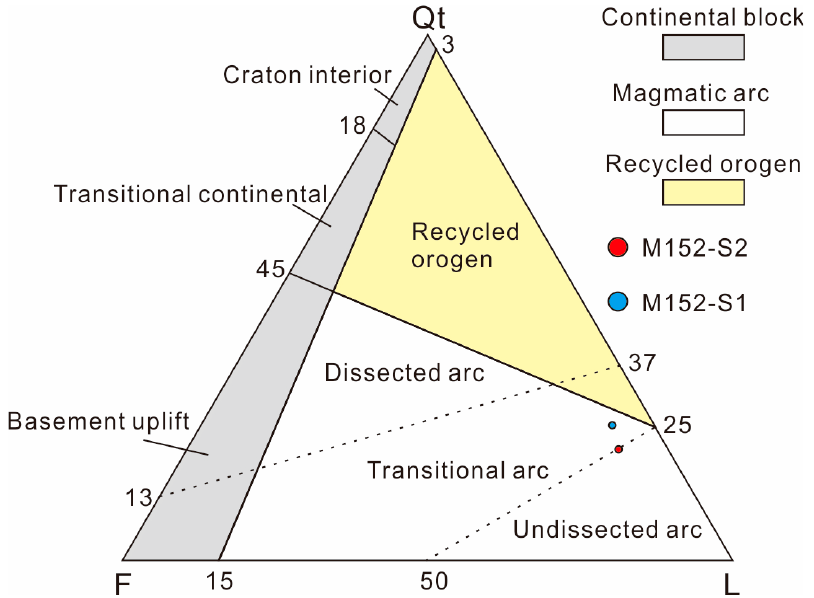
Figure 4. Qt-F-L ternary diagram of modal sandstone grain composition (after reference [29]).